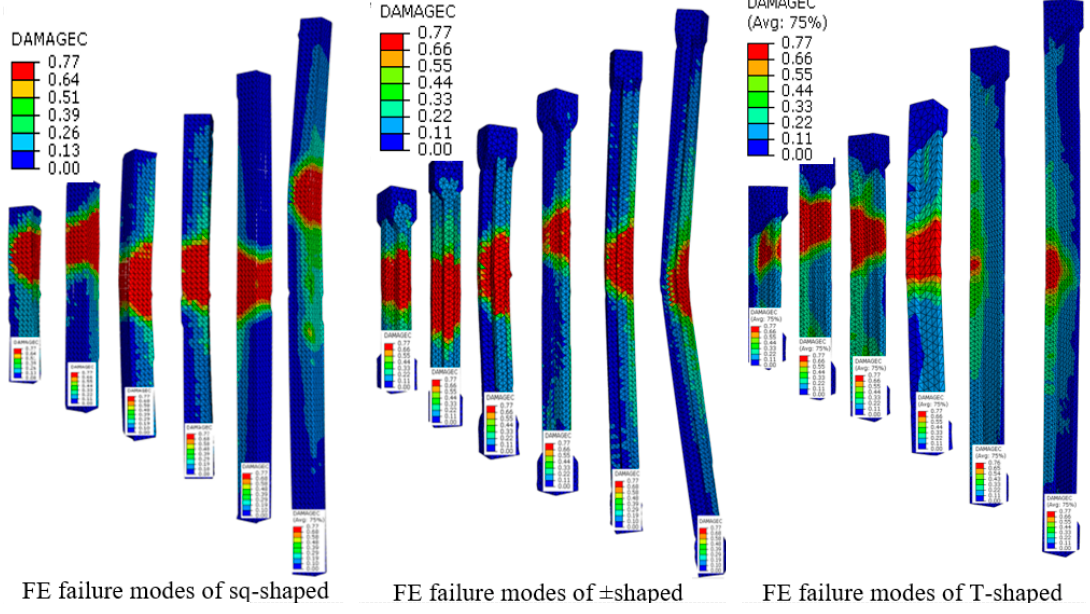
Figure 7. Numerically expected final failure modes of specimens.